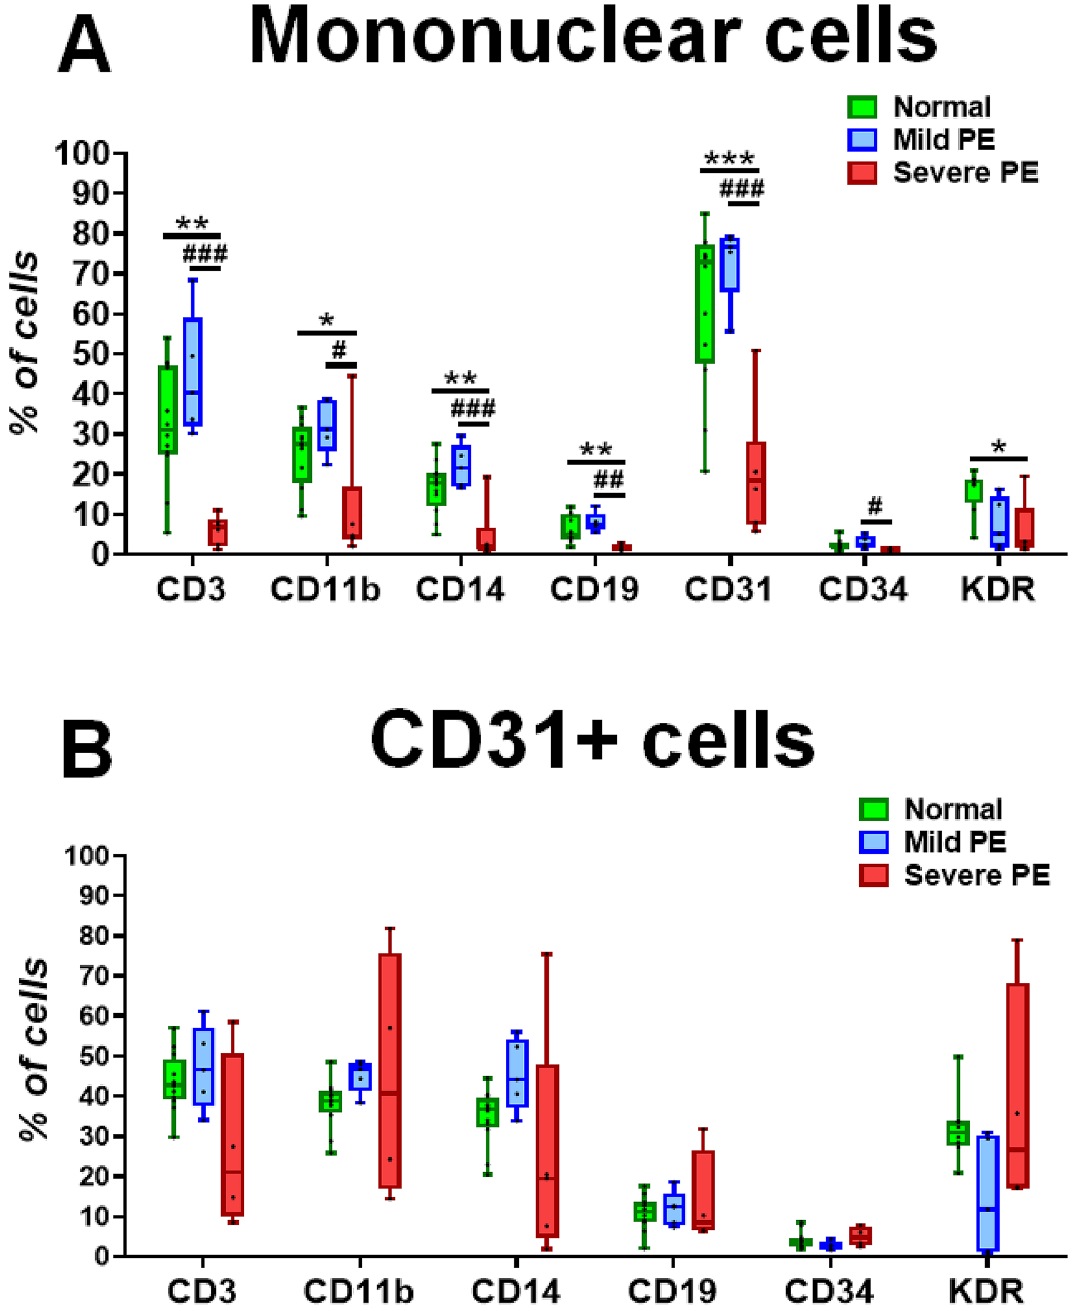
Figure 1. Difference in subpopulations of whole cord blood mononuclear cells and MACS-sorted CD31 + cells between normal, mild PE, and severe PE groups. Flow cytometry analysis for the indicated surface markers. ( A ) Flow cytometry analysis performed on CB-MNCs from normal (n = 8–12), mild PE (n = 5), and severe PE (n = 5–6) groups. ( B ) Flow cytometry analysis performed on CB-CD31 + cells from normal (n = 8–12), mild PE (n = 5), and severe PE (n = 4–5) groups. Statistical analyses were performed with one-way ANOVA followed by Tukey’s multiple comparison. * P < 0.05, ** P < 0.01, *** P < 0.001 for severe PE versus normal; # P < 0.05, ## P < 0.01, ### P < 0.001 for severe PE versus mild PE; $ P < 0.05, $$ P < 0.01, $$$ P < 0.001 for mild PE versus